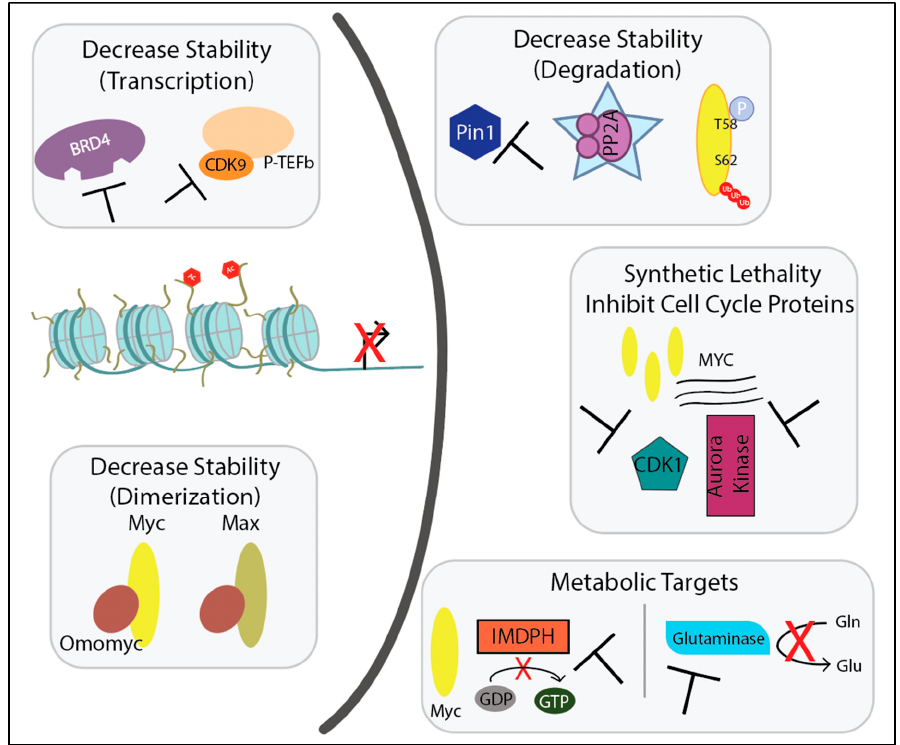
Figure 2. Schematic presenting the various cellular processes to target through inhibition or reactivation in the nucleus ( left ) or cytoplasm ( right ) upon Myc-induced tumorigenesis. All will be described in detail in this review.